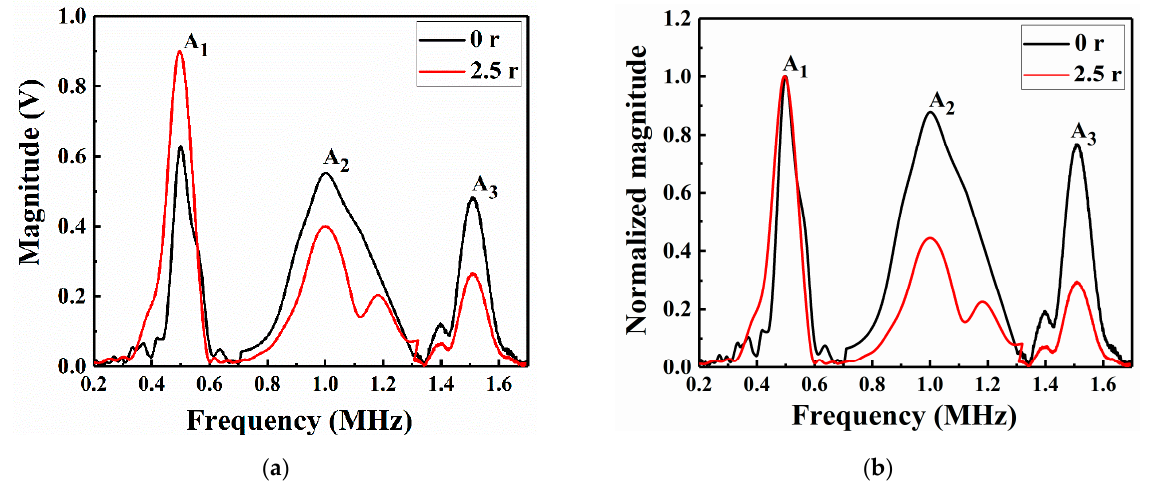
Figure 13. Frequency-domain responses in the experiments with the unrepaired and repaired CFRP laminates: ( a ) actual amplitude and ( b ) normalized amplitude.